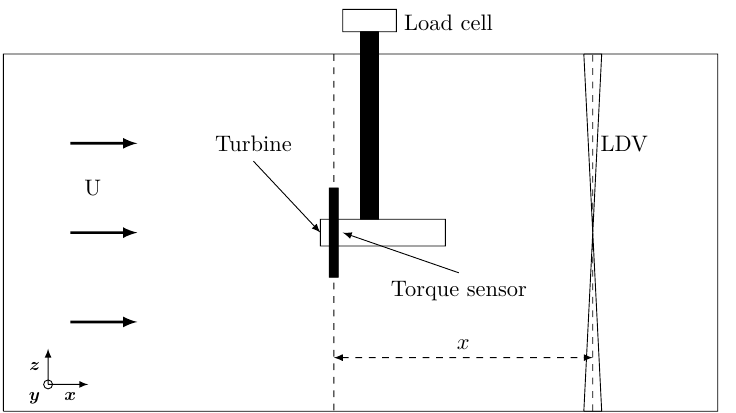
Figure 4. Experimental set-up of Mycek et al. [6]. The of the coordinate system’s origin is the rotor